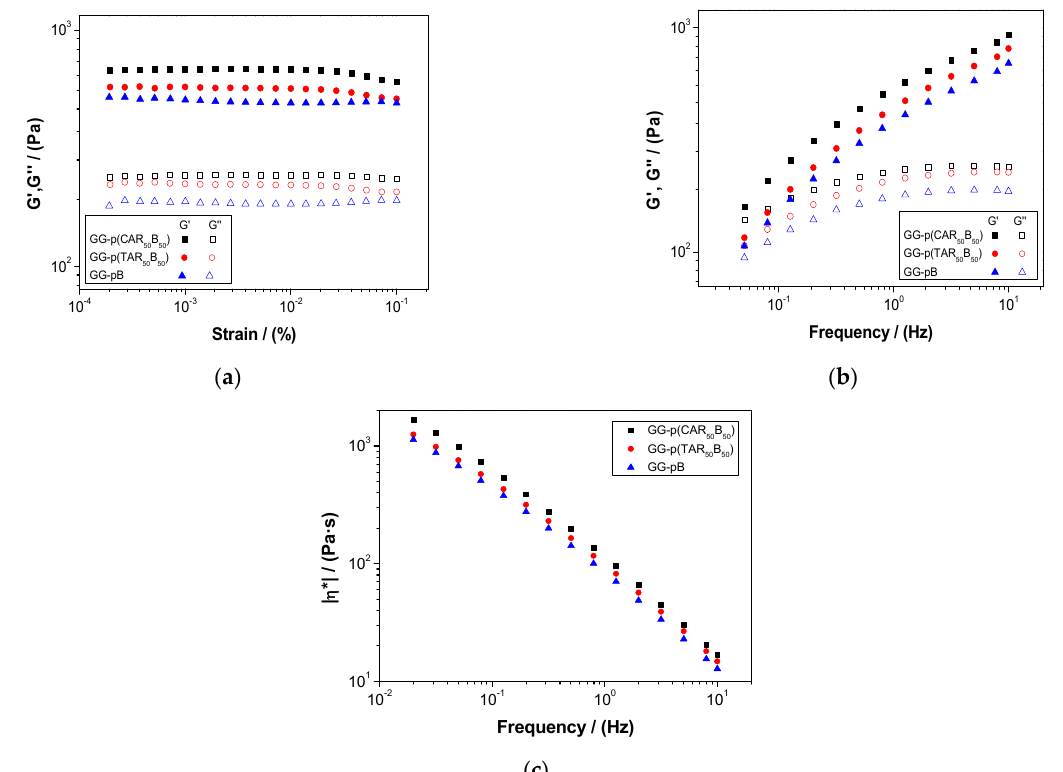
Figure 8. ( a ) Strain sweep tests of the different systems evaluated: GG ‐ p(CAR 50 B 50 ), GG ‐ p(TAR 50 B 50 ), and GG ‐ pB. ( b ) Frequency sweep tests of the different systems evaluated: GG ‐ p(CAR 50 B 50 ), GG ‐ p(TAR 50 B 50 ), and GG ‐ pB. ( c ) Evolution of the viscosity over the frequency range studied for the different systems evaluated: GG ‐ p(CAR 50 B 50 ), GG ‐ p(TAR 50 B 50 ), and GG ‐ pB.